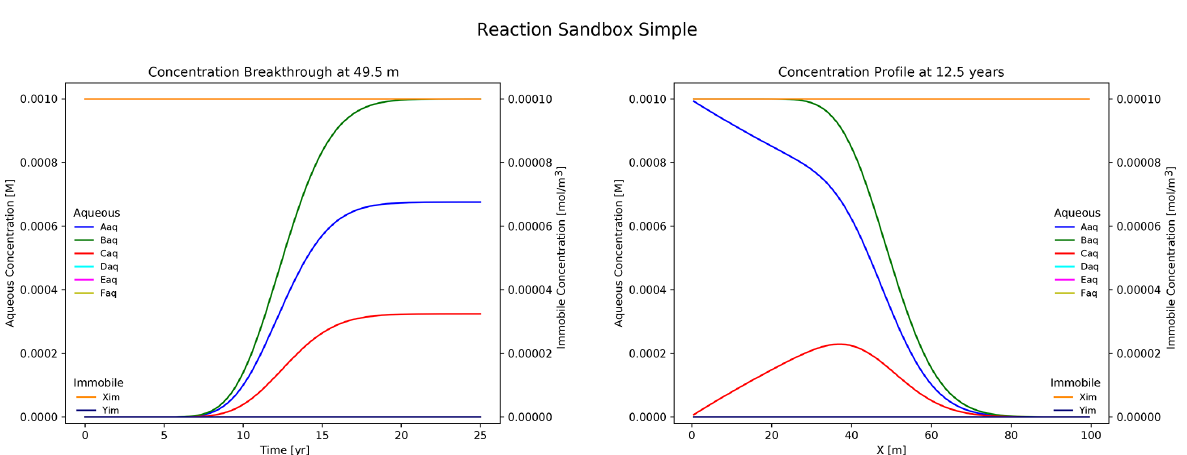
Figure 5. Results from Reaction Sandbox Simple with the first-order A → C rate expression